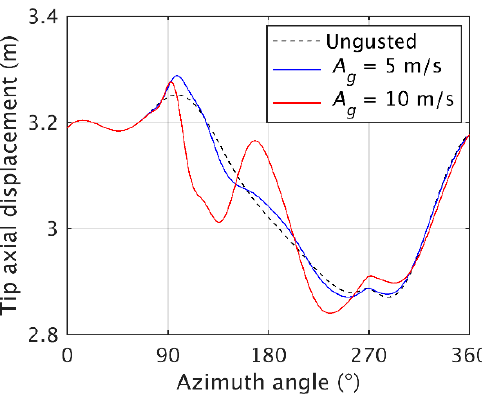
Figure 15. The 1 + cos gusts: tip axial displacement as a function of its azimuth angle in all analyzed cases. Lastly, the torque provided by the blade hit by the gust is given in Figure 16.